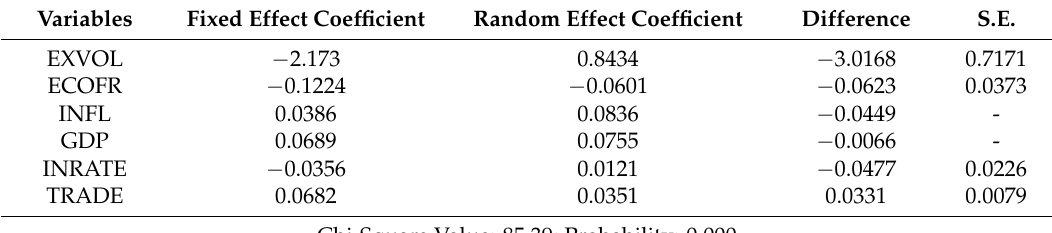
Table A9. Hausman Test: FDI and Exchange Rate Volatility (GARCH).